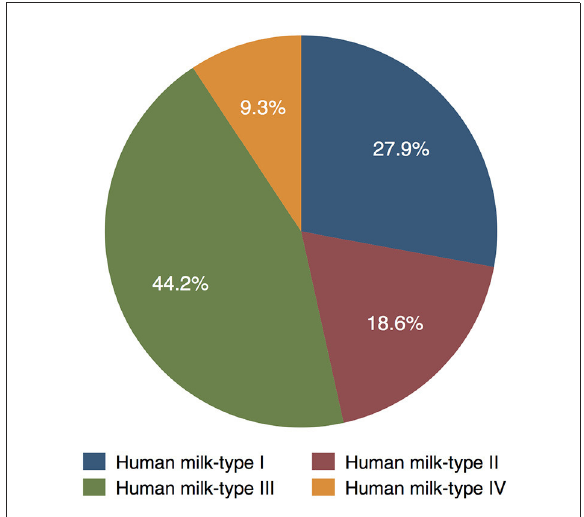
FIGURE2 Distribution of HM-types among women in the MITICA cohort (as percentage of the 43 women with HM samples).